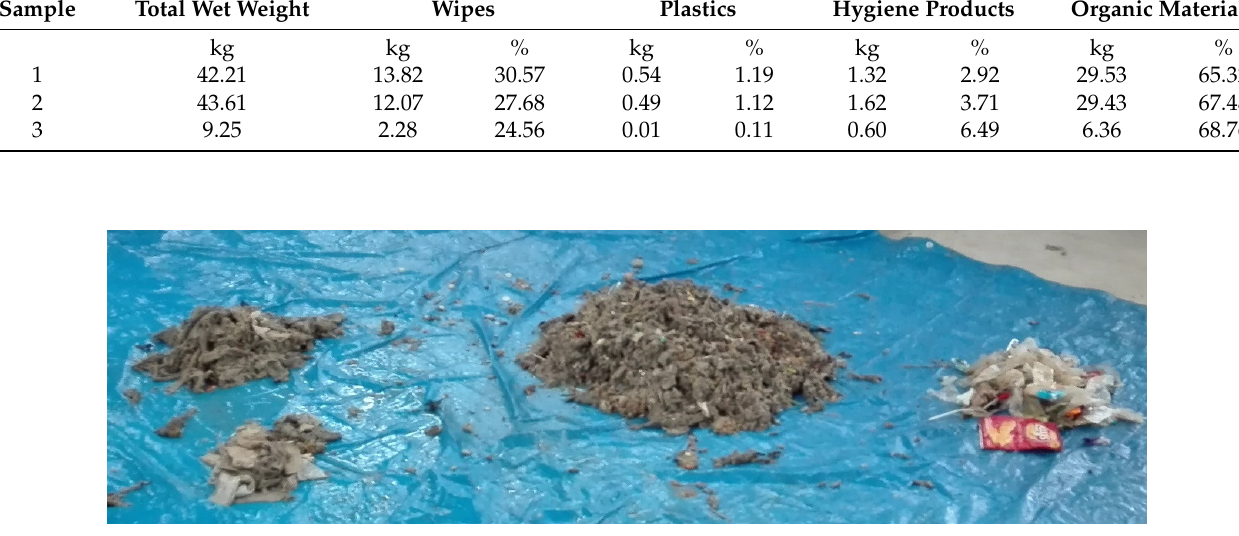
Figure 3. Gross solids sample removed in pretreatment at Villapérez WWTP. Table 2. Composition of gross solids samples from pretreatment at Villapérez WWTP.